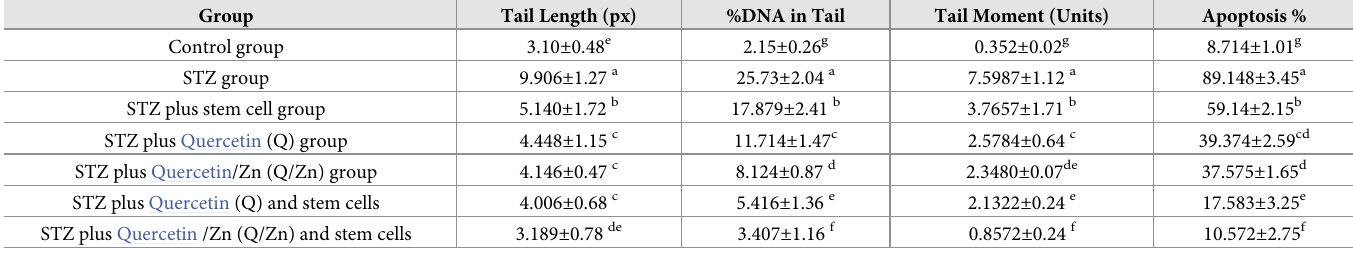
Table 9. The effect on oxidative DNA damage level (tail length, DNA% and tail moment) and apoptotic cell population (apoptosis %) in Pancreas of control and treated male rats with quercetin, quercetin/Zn, or stem cells and their